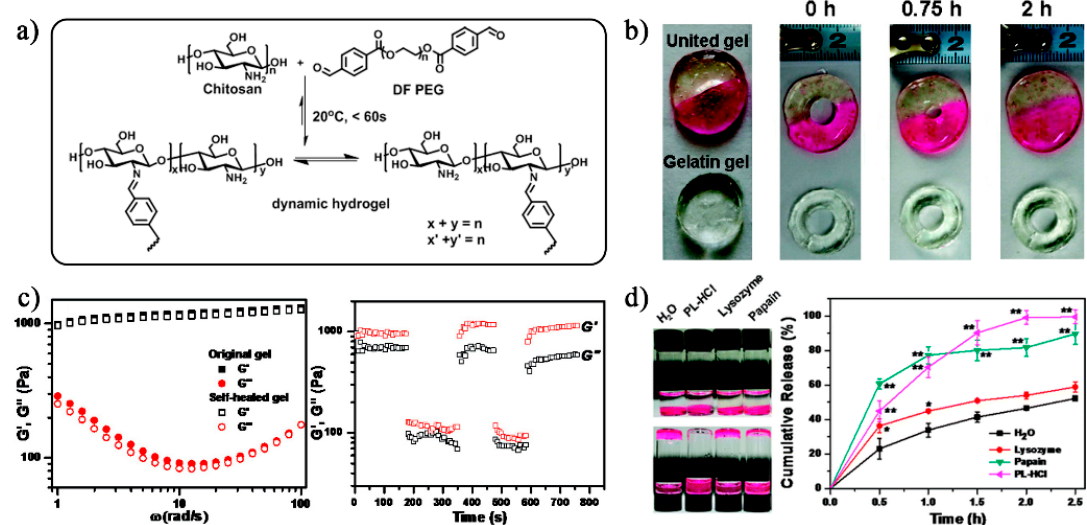
Figure 1. ( a ) The schematic illustration of the dynamic hydrogel; ( b ) the self-healing process between two different colored semicircle hydrogels; ( c ) left : storage modulus G’ (black squares) and loss modulus G’’ (red ciecles) of the original (solid) and the self-healed (hollow) hydrogel; right : G’ (red hollow squares) and G’’ (black hollow suqares) in continuous step strain experiments; and ( d ) the photos and the plots of cumulative release of rhodamine B under different conditions. Reprinted with permission [34]. Copyright 2011, American Chemical Society.